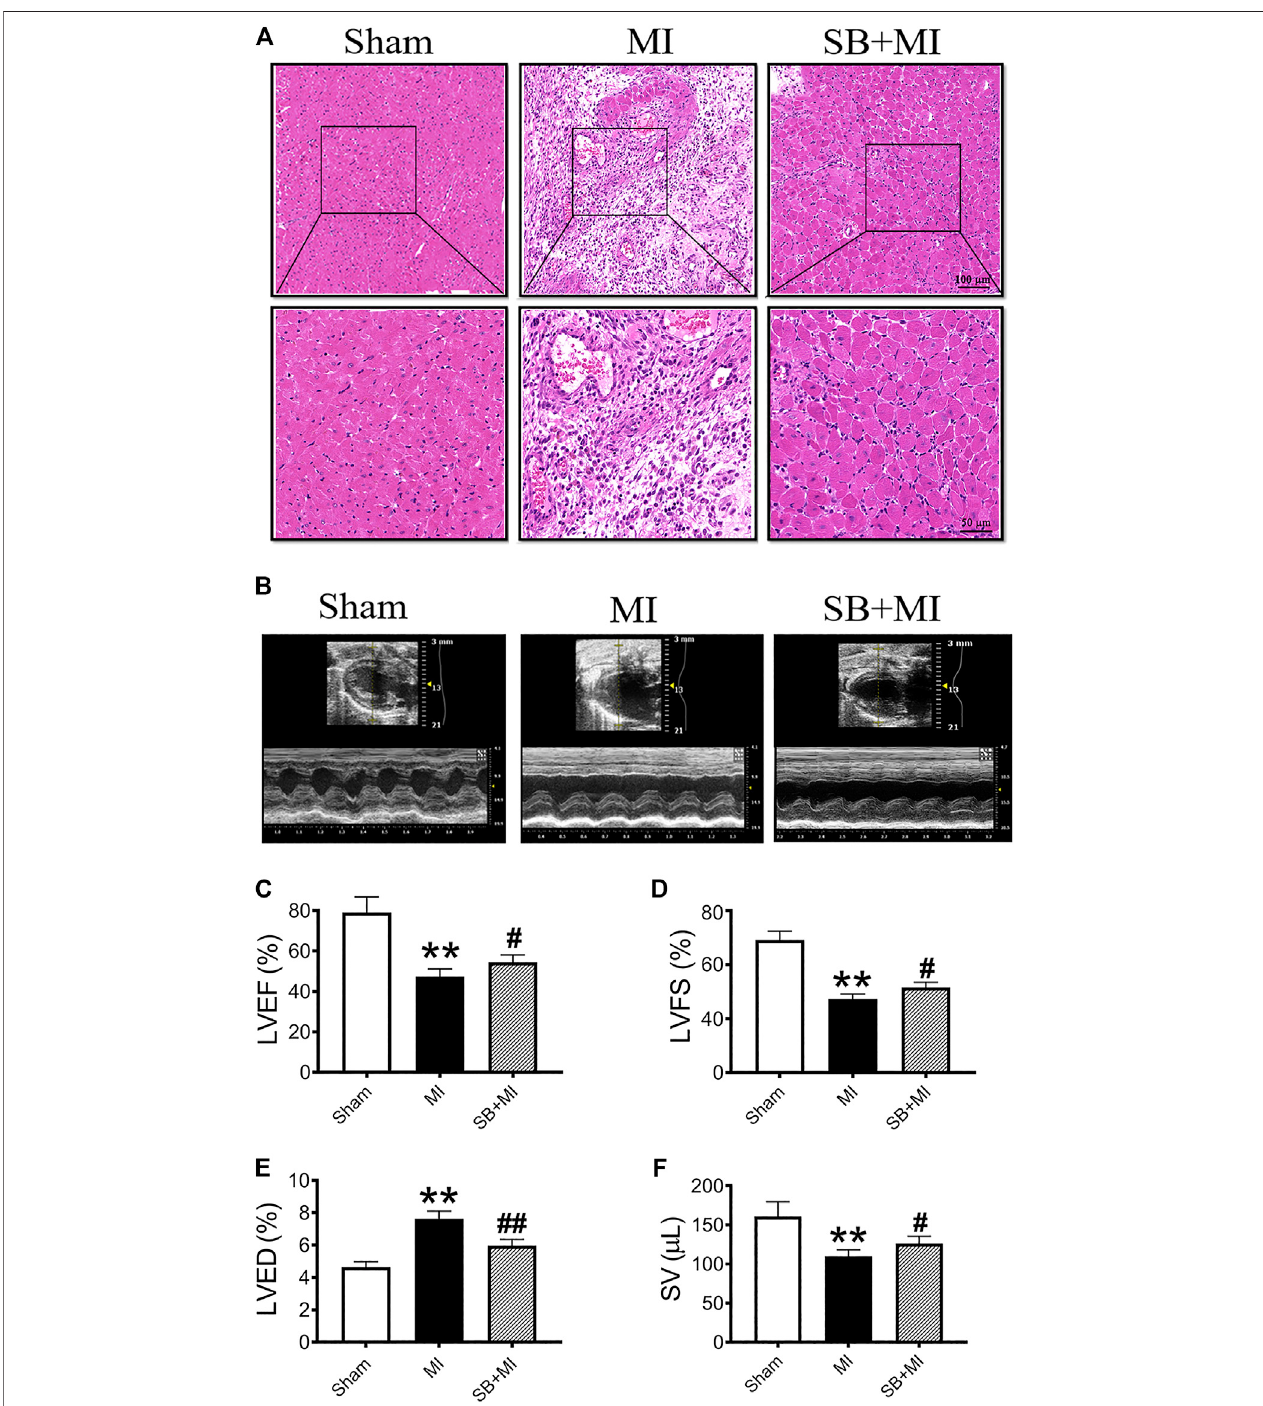
FIGURE 1 | GSK-3 β inhibition alleviates cardiac function damage after MI. (A) . Representative images of heart sections obtained 7 days after MI and stained with H&E( n (cid:2) 3/group).Scalebars: fi rstrow,100 μ m(H&E × 100)andsecondrow,50 μ m(H&E × 200). (B) CardiacfunctionwasevaluatedusingaVevo2,100high-resolution micro-imagingsystemat7 days afterMI.M-mode echocardiographicimagingobtained7 daysafterMI. (C – F) Echocardiographicparameter analysisofLVEF (C) ,LVFS (D) , LVED (E) , and SV (F) ( n (cid:2) 7/group). Data are presented as the mean ± SD. ** p < 0.01 vs. Sham group; # p < 0.05, ## p < 0.01 vs. MI group.